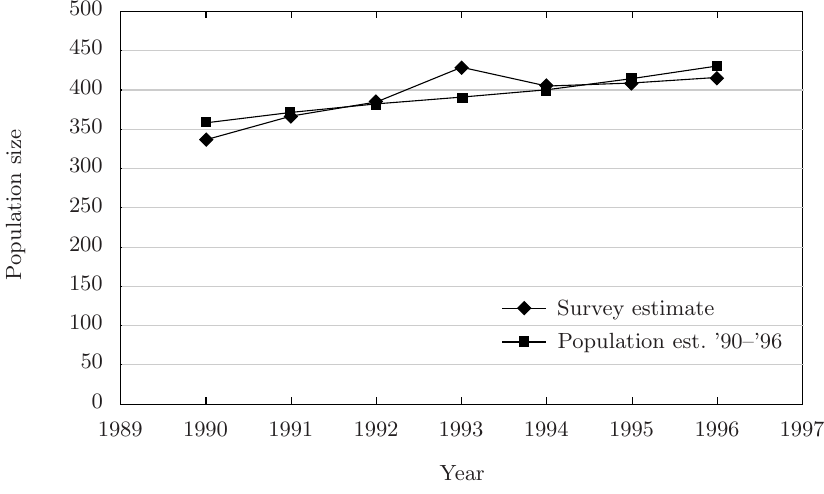
Figure 3: Black rhino surveys and population estimates from